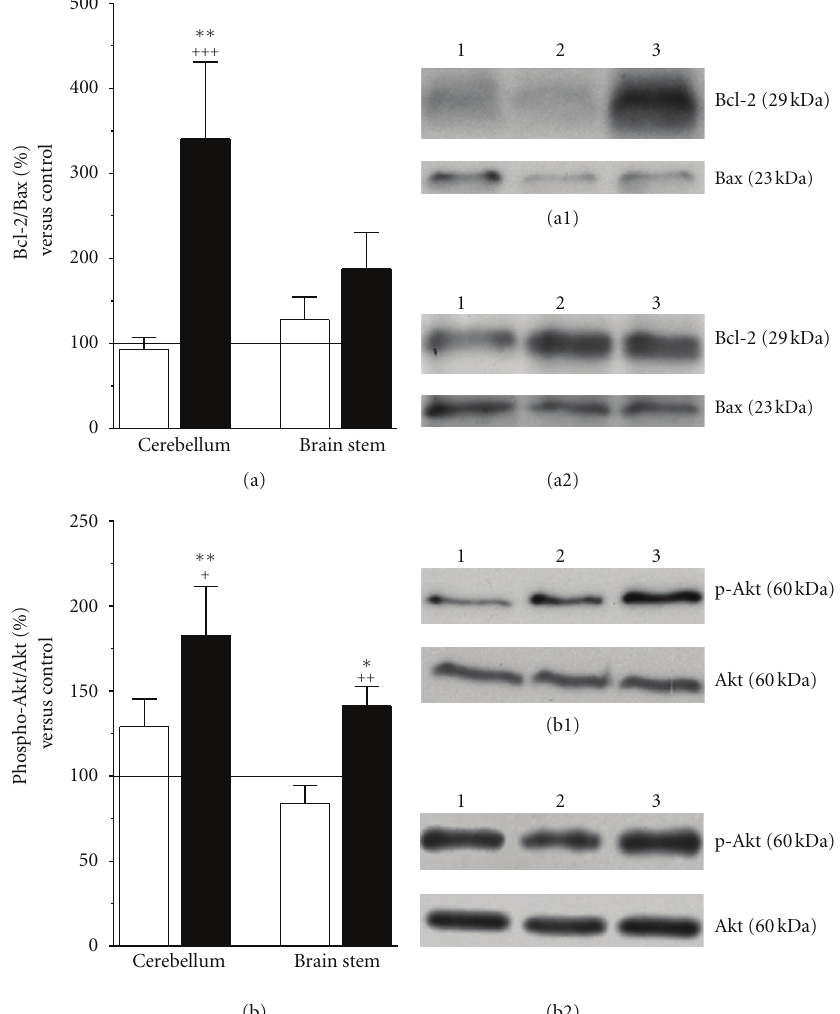
Figure 7: HuUCBMCs grafts upregulate Bcl-2 and phospho-Akt protein levels in the cerebellum and brain stem of 3-AP ataxic rats. HuUCBMCs transplantation raises the ratio Bcl2/Bax in the cerebellum of 3-AP-lesioned rats (a, black bars). Note how this e ff ect is due to an increase in the expression of the antiapoptotic protein Bcl-2 (a1). HuUCBMCs also upregulate the ratio phospho-Akt/Akt in the cerebellum and brain stem of 3-AP ataxic rats (b, black bars). In both structures cell transplantation significantly enhances phospho-Akt levels (b1, b2), which is a protein involved in neuronal survival. (a1) and (a2) show representative blots for Bcl-2 and Bax, and (b1) and (b2) for phospho-Akt and Akt in the cerebellum (a1, b1) and brain stem (a2, b2). Lane 1: na¨ıve rats (control); lane 2: 3-AP-lesioned rats treated with vehicle (3-AP + vehicle); lane 3: 3-AP-lesioned rats treated with HuUCBMCs grafts (3-AP + cells). Results represent the mean ± SEM of 9 to 15 individual animals. ∗ P ≤ 0 . 05, ∗∗ P ≤ 0 . 01 versus na¨ıve rats, + P ≤ 0 . 05, ++ P ≤ 0 . 01, +++ P ≤ 0 . 001 versus 3-AP + vehicle